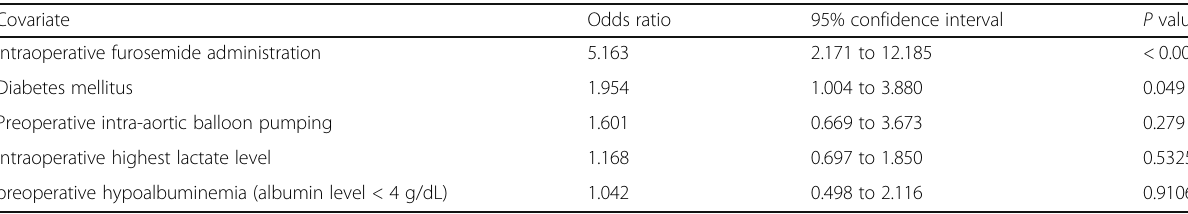
Table 4 Results of multivariable logistic regression analysis for postoperative AKI Covariate Odds